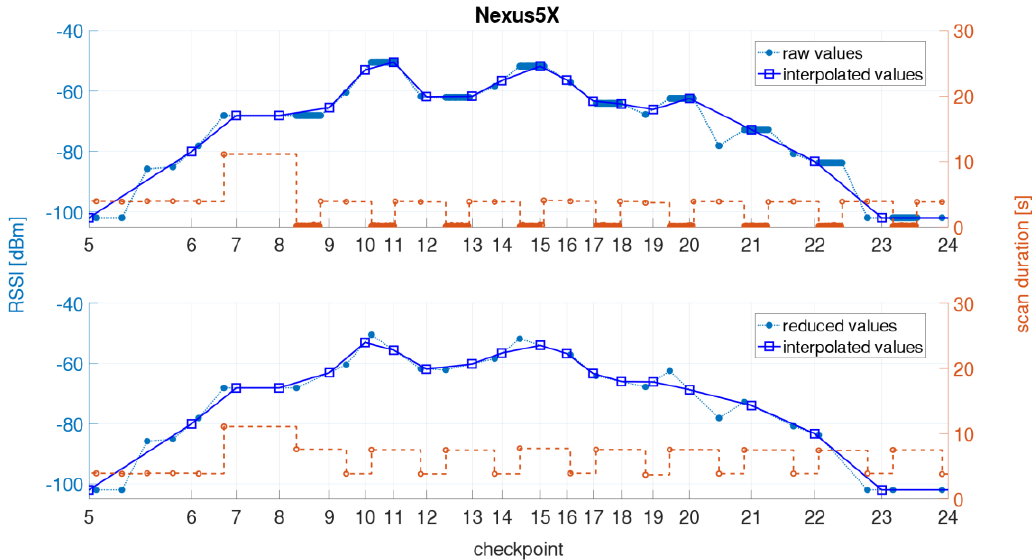
Figure 12. Kinematic measurements with the Nexus 5X smartphone with ( top ) raw and ( bottom ) interpolated RSSI values in dependence on the scan duration.